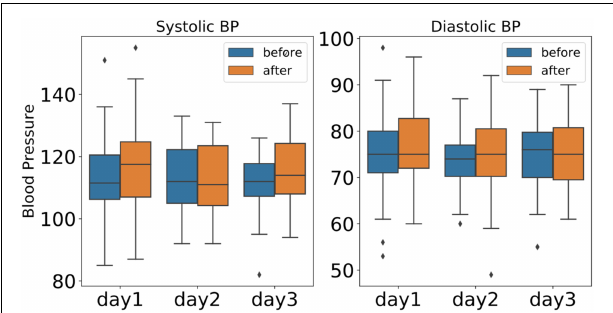
FIGURE 12 | The boxplots of systolic and diastolic blood pressure from all the subjects over the course of 3 days (blue: before cold pressor test, orange: after cold pain test).